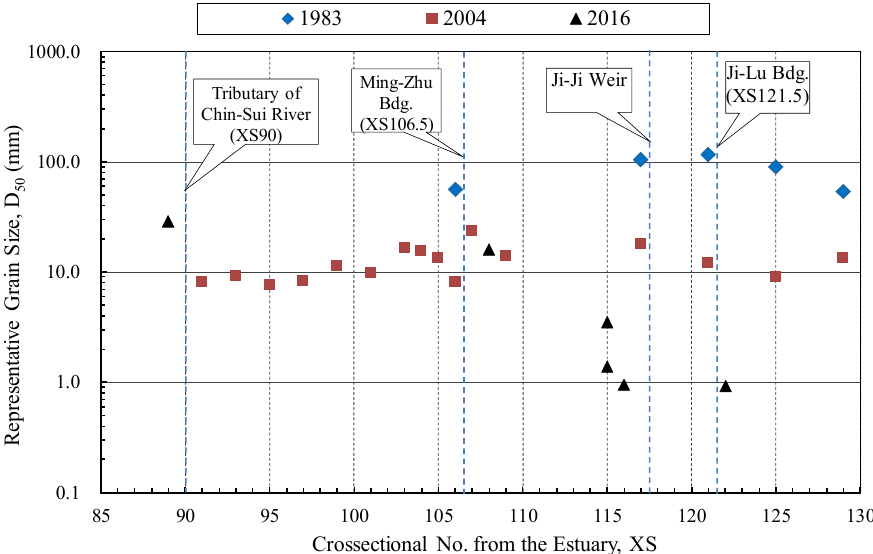
Figure 3. Variations of the bed material size in three different years.